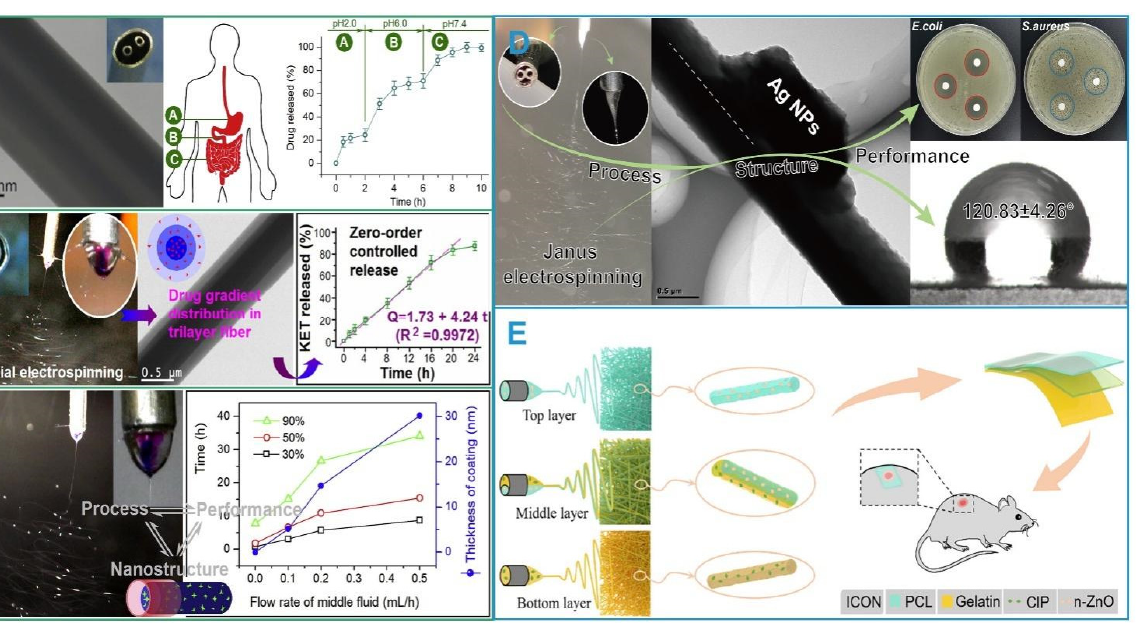
Figure 8. Significance of specially structured nanofibers. ( A )The sheath-separate-core structures for targeted drug delivery [88]; ( B ) Triple-layer nanofibers for zero-order drug release, reprint permission from ref. [90]. Copyright 2015, American Chemical Society; ( C ) Triaxial electrospinning for zero-order controlled release, reprint permission from ref. [27]. Copyright 2019, Elsevier; ( D ) Nanofibers with synergistic antibacterial effect for wound dressing [92]; ( E ) Multilayer nanofibers as wound dressing, reprint permission from ref. [93]. Copyright 2022, Elsevier.